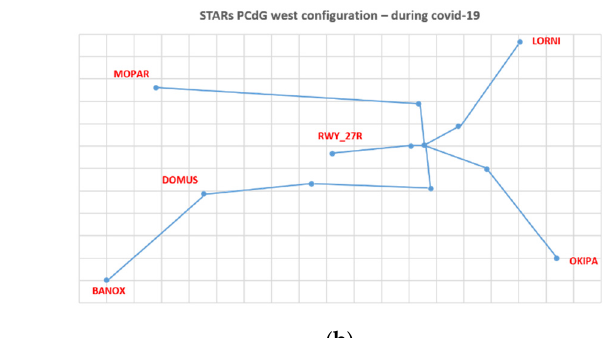
6 of 21 Table 1. Characteristics of the ground side element during COVID-19. Ground Side Element